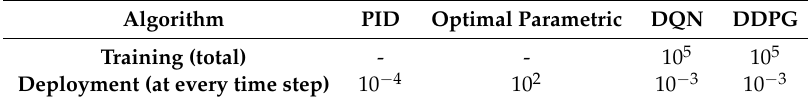
Table 5. Order of magnitude of the mean computational time (in seconds) required by each algorithm during training and